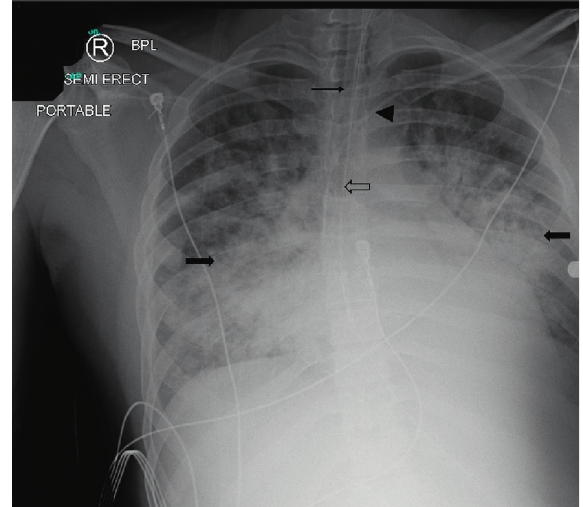
2: Chest X-ray obtained after endotracheal intubation showing extensive bilateral airspace consolidation (identified by block arrows with color fill) with some sparing of the apices. Tip of the endotracheal tube at the level of the clavicular heads (arrow). Nasogastric tube (block arrow without color fill) and right sub- clavian line (arrowhead) in